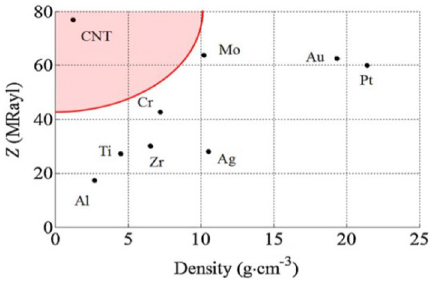
Fig. 14 Density and acoustic impedance of commonly used electrode metals, produced by